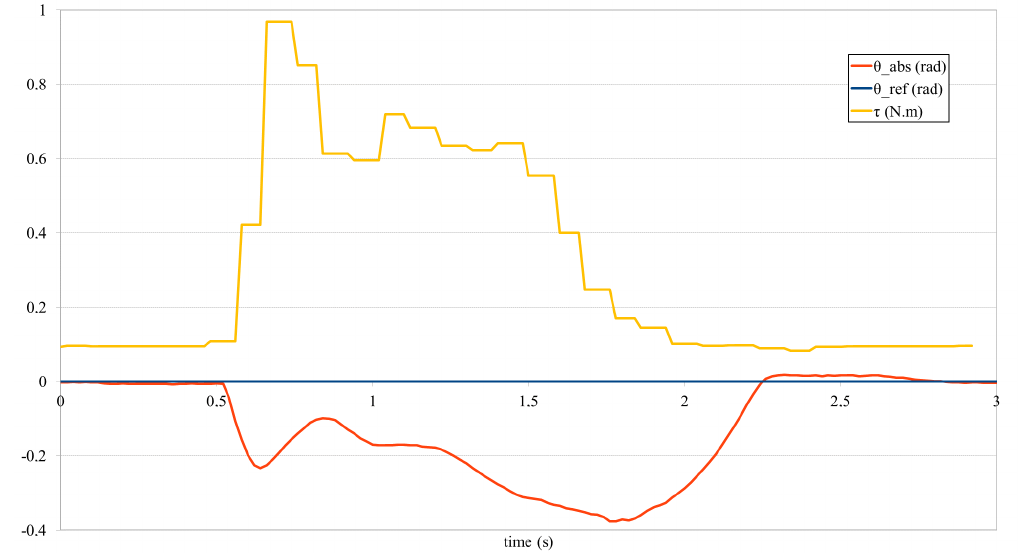
Figure 20. Compliant Controller Disturbance Rejection with Position reference and Force limit